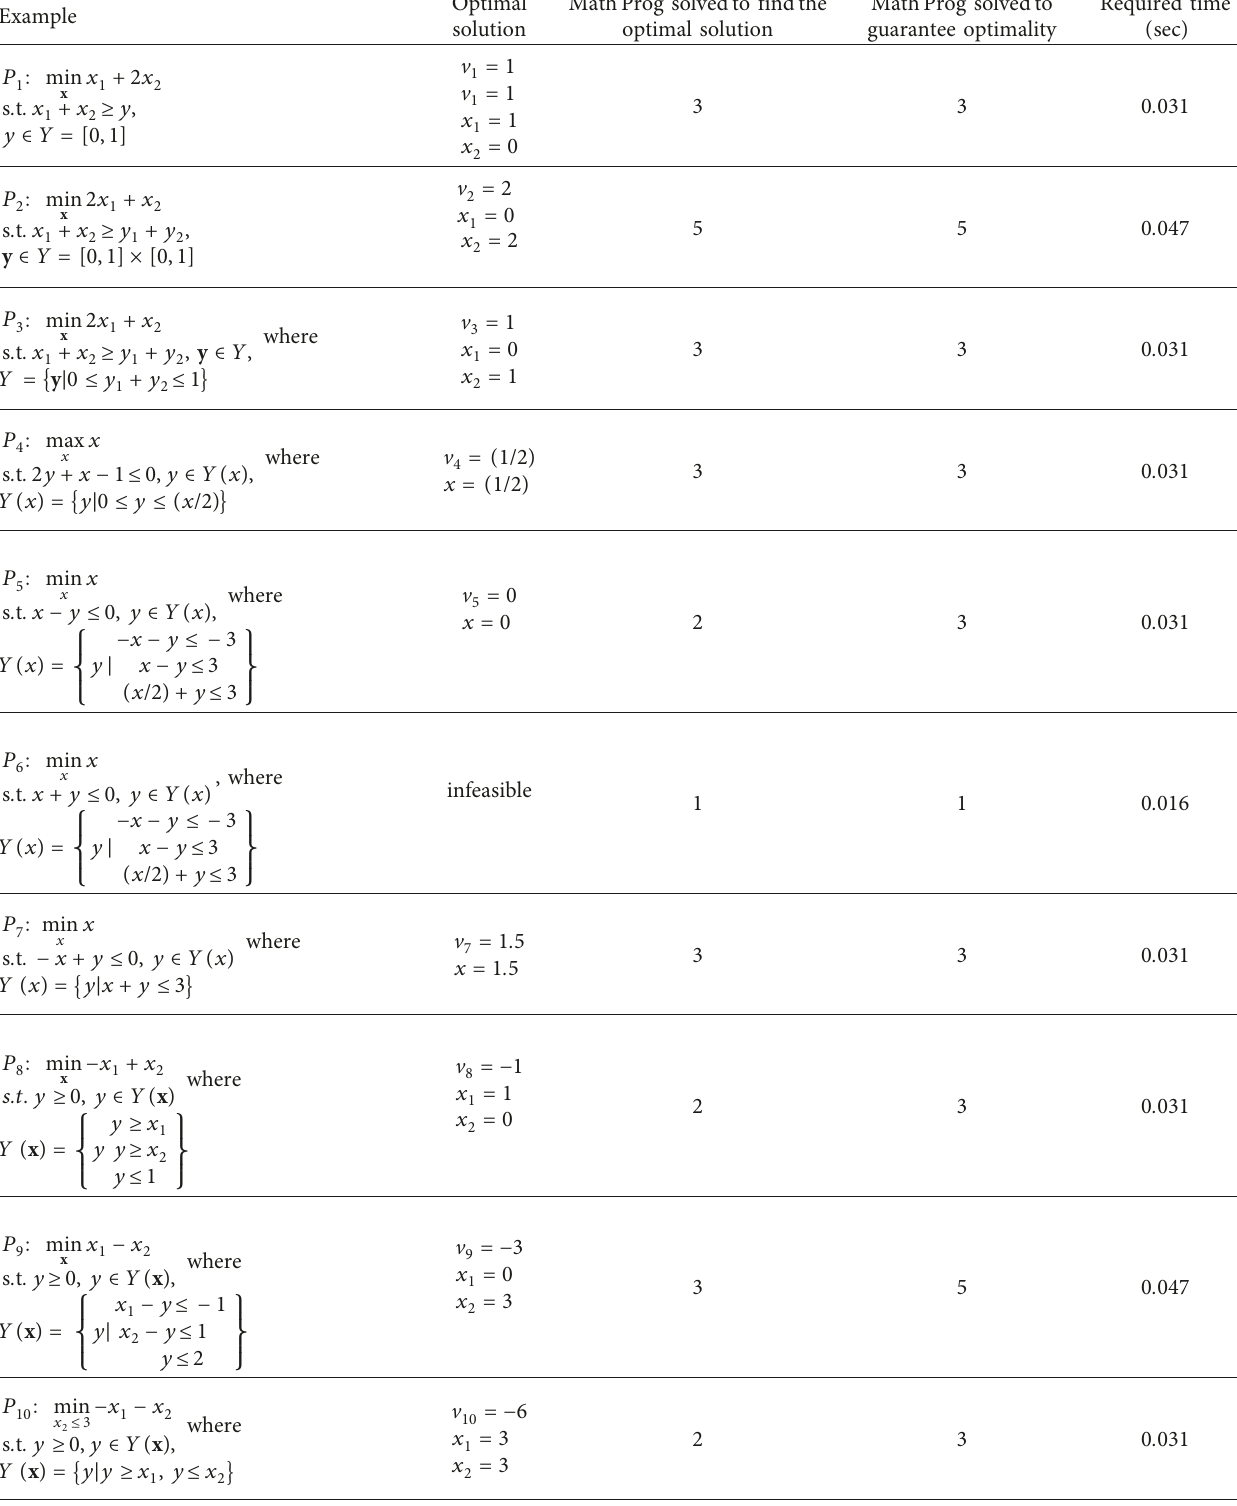
Table 1: Results in linear semi-infinite